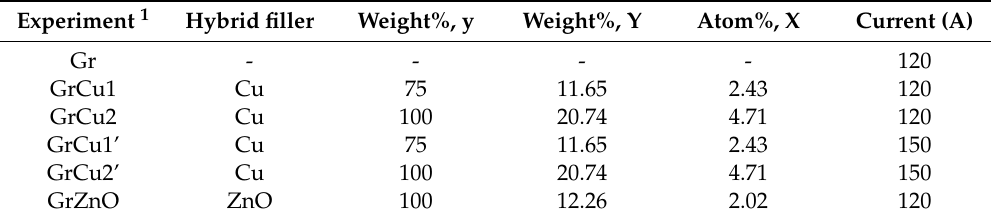
Table 1. Experimental conditions for graphene and graphene hybrids